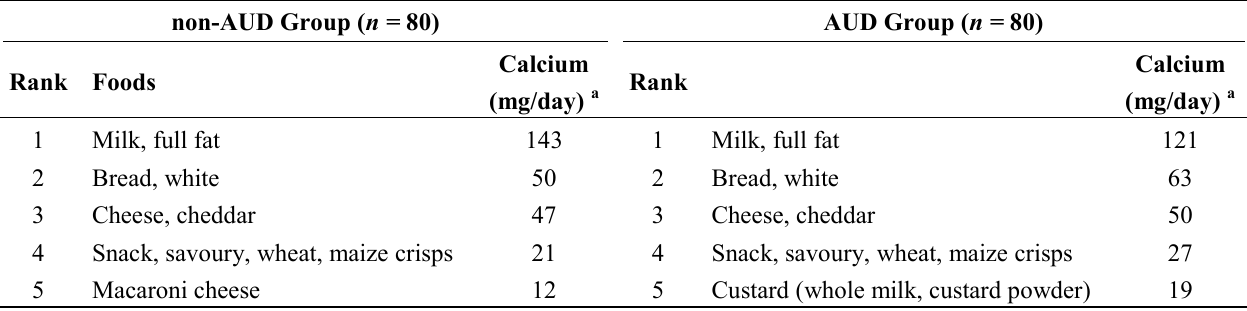
Table 5. Top five foods/energy-containing beverages contributing to calcium intake (milligrams per day) in the non-AUD and AUD